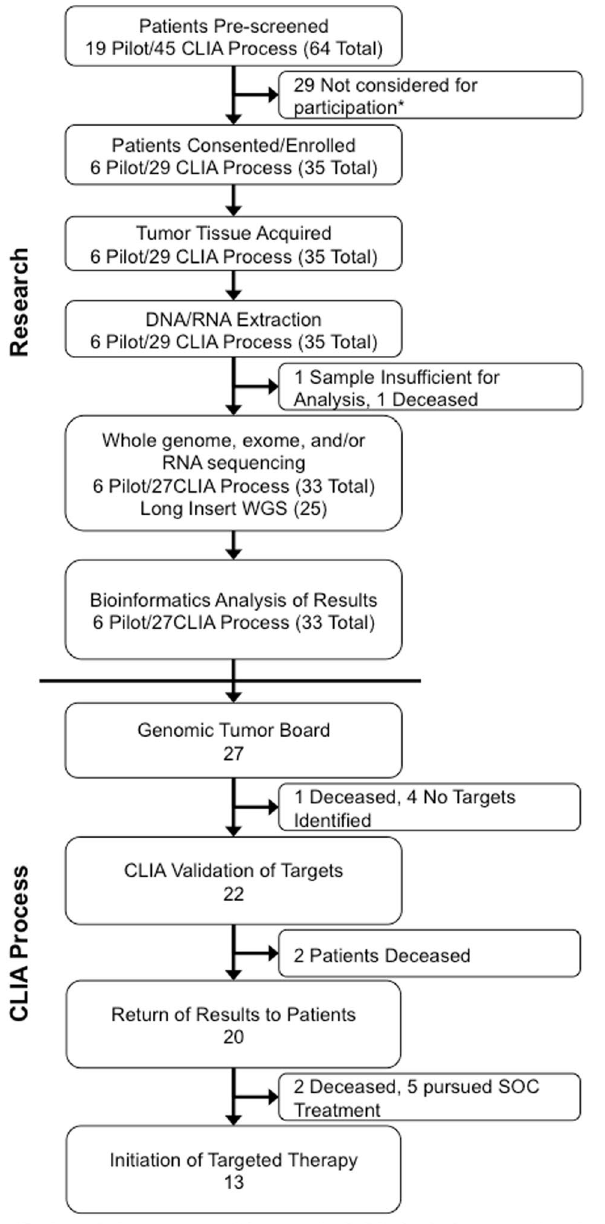
Figure 1. CONSORT Diagram of the sequencing workflow used in this pilot study including the number of patients at each